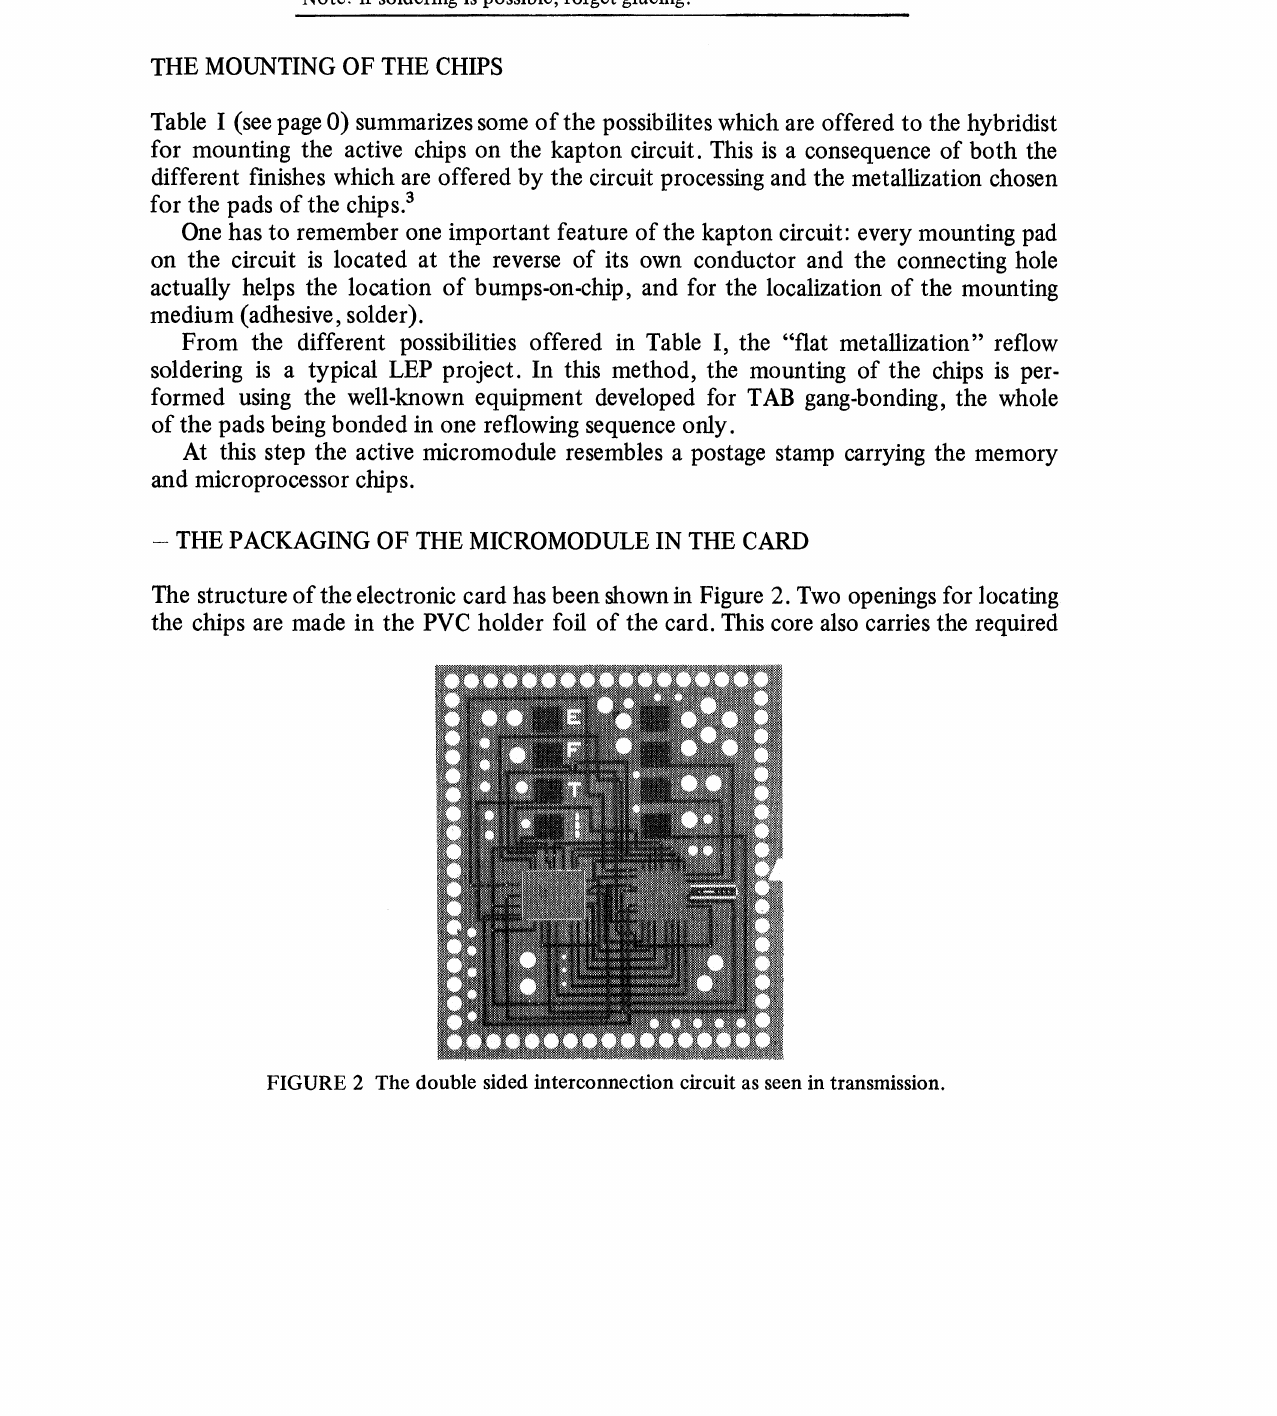
FIGURE 2 The double sided interconnection circuit as seen in